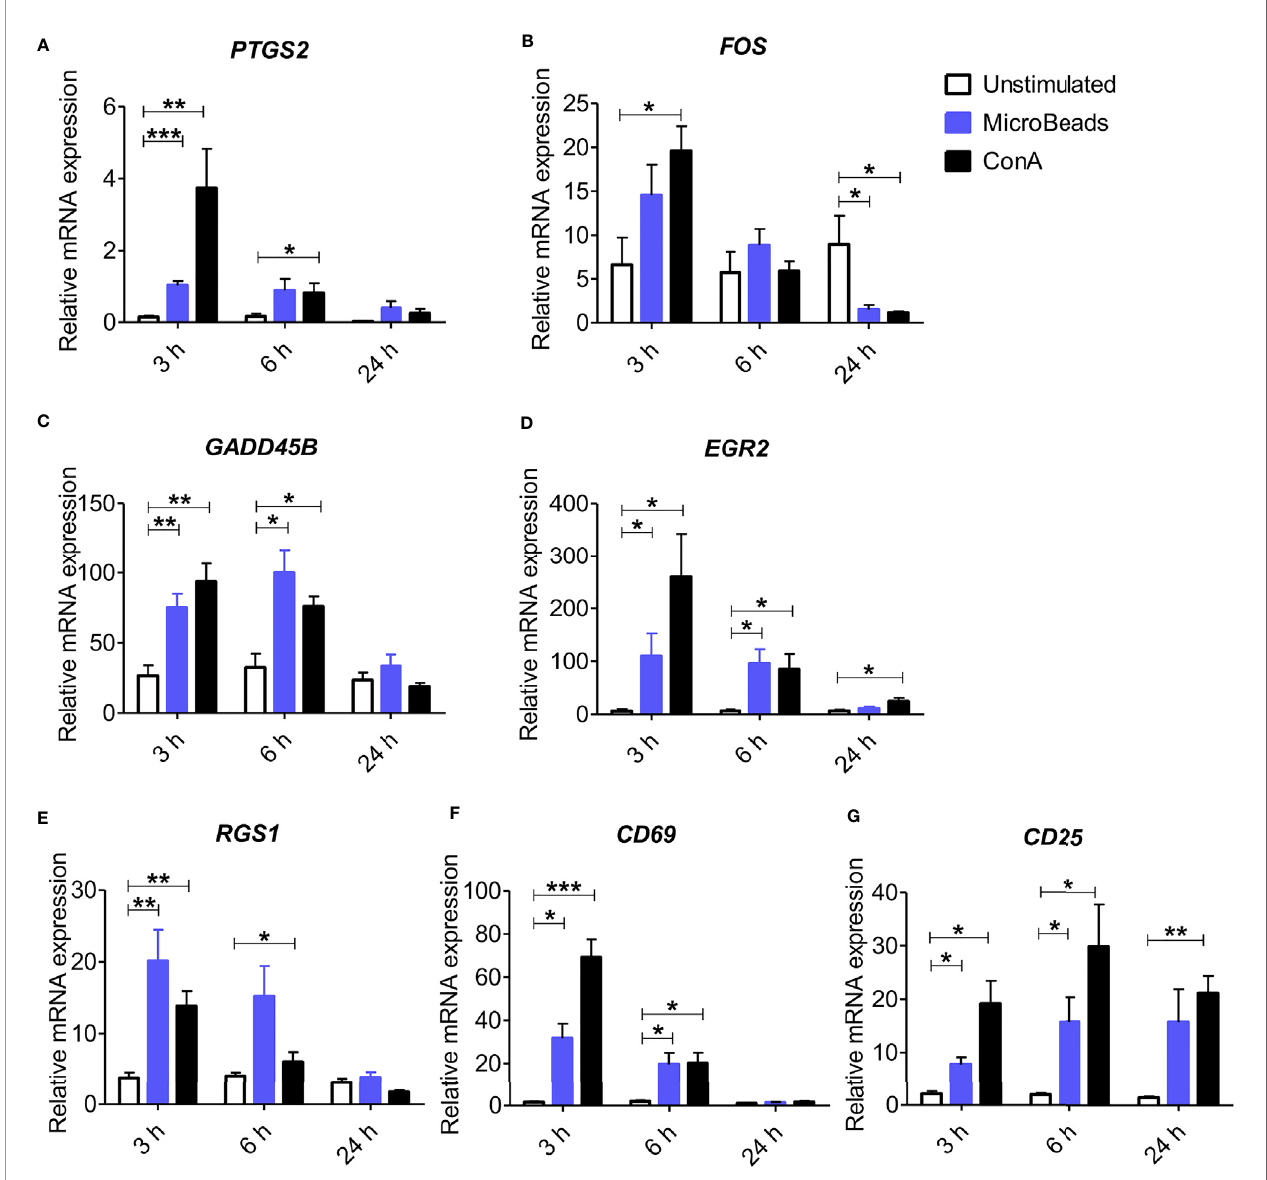
FIGURE 1 | Application of nano-sized magnetic beads coated with anti-canine CD3 and CD28 antibodies (MicroBeads) increases the expression of genes associated with early stages of activation determined by Real-time PCR. Bar graphs showing relative mRNA expression of PTGS2 (A) , FOS (B) , GADD45B (C) , EGR2 (D) , RGS1 (E) CD69 (F) and CD25 (G) in unstimulated canine peripheral blood lymphocytes (PBLs) and after stimulation with MicroBeads (1:0.5 T cell: MicroBead ratio) and plant mitogen Concanavalin A (ConA). The analysis was performed using cells from 4 healthy dogs (n=4), in triplicates. Statistical analysis was performed by unpaired Student ’ s t -test (* p < 0.05,** p < 0.01, *** p <